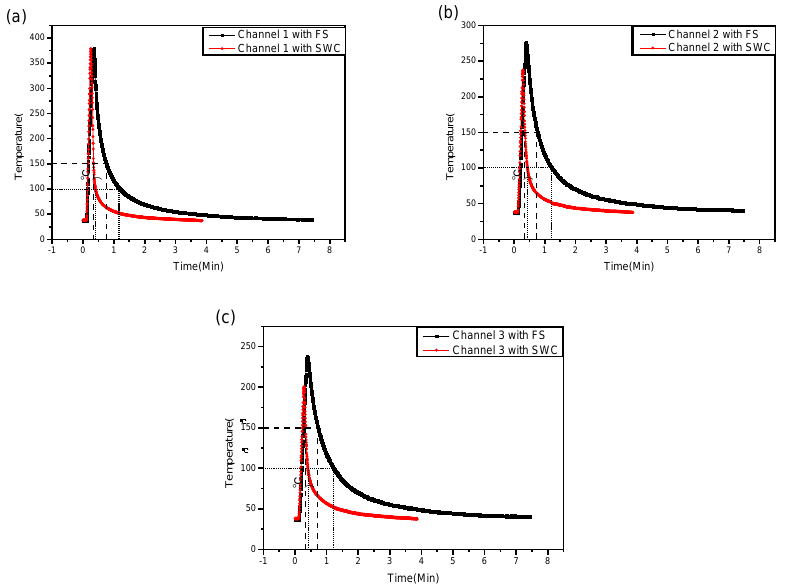
Figure 6. Temperature profiles of CH 1, CH 2, and CH 3 under different conditions: ( a ) CH 1, ( b ) CH 2, and ( c ) CH 3.